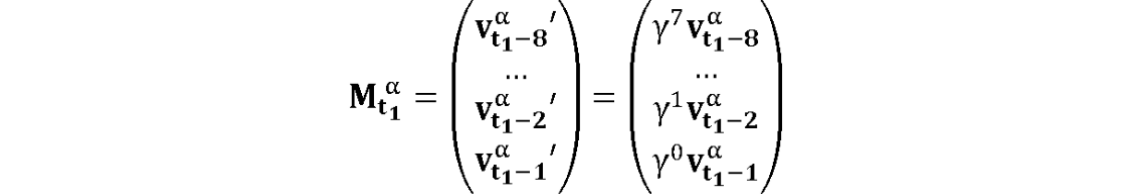
Figure 4. Sequential multiplex matrix of the subject α on the 1st image chunk, where t 1 =9.